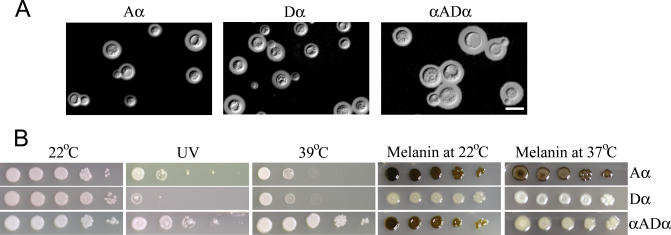
In Vitro Assays of Virulence AttributesSerotype A (H99, Aα) and D (JEC21, Dα) reference stains and the isogenic laboratory-constructed AD hybrid (XL1462, αADα) were grown in liquid YPD medium overnight and washed three times with distilled water. Cell concentration was determined by optical density at 600 nm. Cells were then incubated on DMEM for 3 d and examined microscopically with India ink to reveal capsules (A). Three microliters of serial dilutions (10×) of cells (from overnight cultures in YPD) at the same concentration were spotted onto the indicated media for phenotypic characterization (B). Cells were grown on YPD medium at 22 °C as controls for growth (first column). Cells on YPD medium were subjected to UV irradiation for 12 s (∼48 mJ/cm2) and then incubated at 22 °C (second column). Cells were grown on YPD medium at 39 °C (third column). Cells were grown on L-DOPA medium at 22 °C (fourth column) or 37 °C (fifth column) to assay melanin pigmentation.